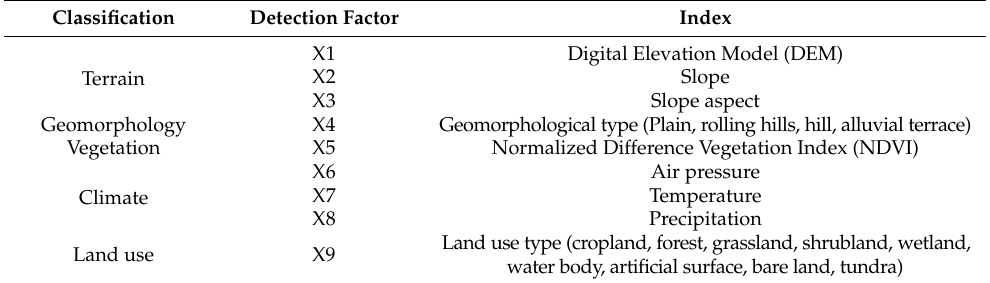
Table 1. Driving factors for the Geographic detectors.